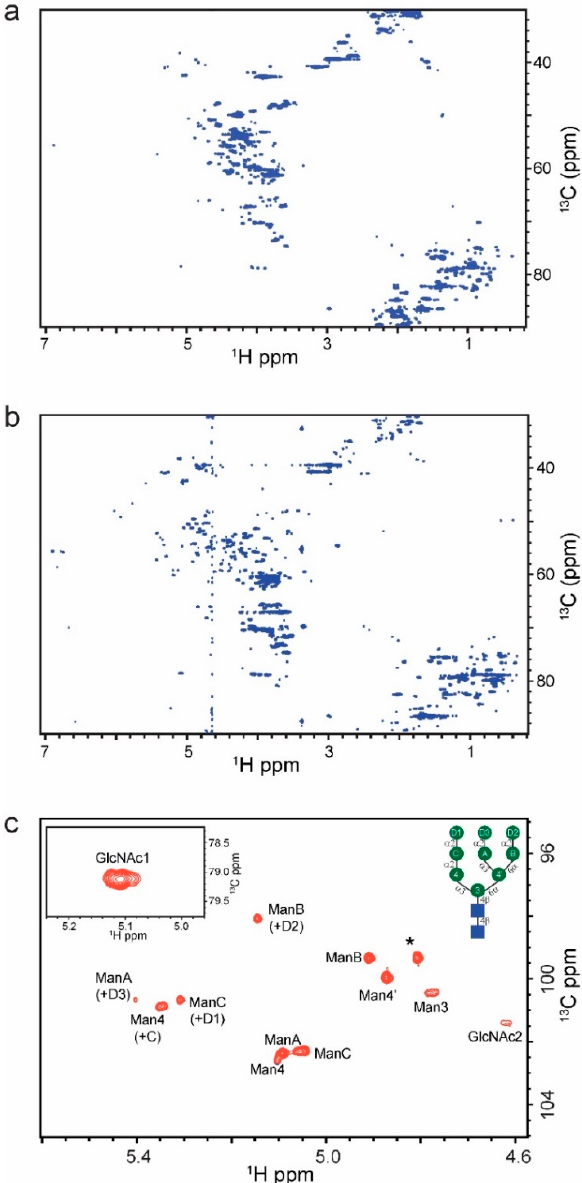
Figure 4. 2D 1 H- 13 C HSQC of ( a ) 1.4 mM vendor 1 RNase B and ( b ) 1.0 mM vendor 2 RNase B. Glycan anomeric region and ring region are the same between the two vendors; however, the vendor 2 spectrum contains additional peaks from 2.5 to 3.0 ppm in 1 H and 30 to 40 ppm in 13 C that are not present in the RNase B vendor 1 spectrum. ( c ) Vendor 1 glycan anomeric signals used for quantitative analysis (inset: schematic of Man 9